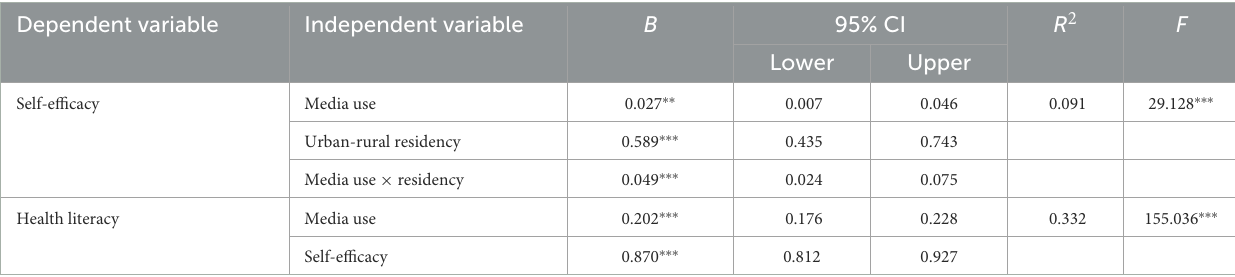
TABLE 6 Path-coefficients of the moderated mediating